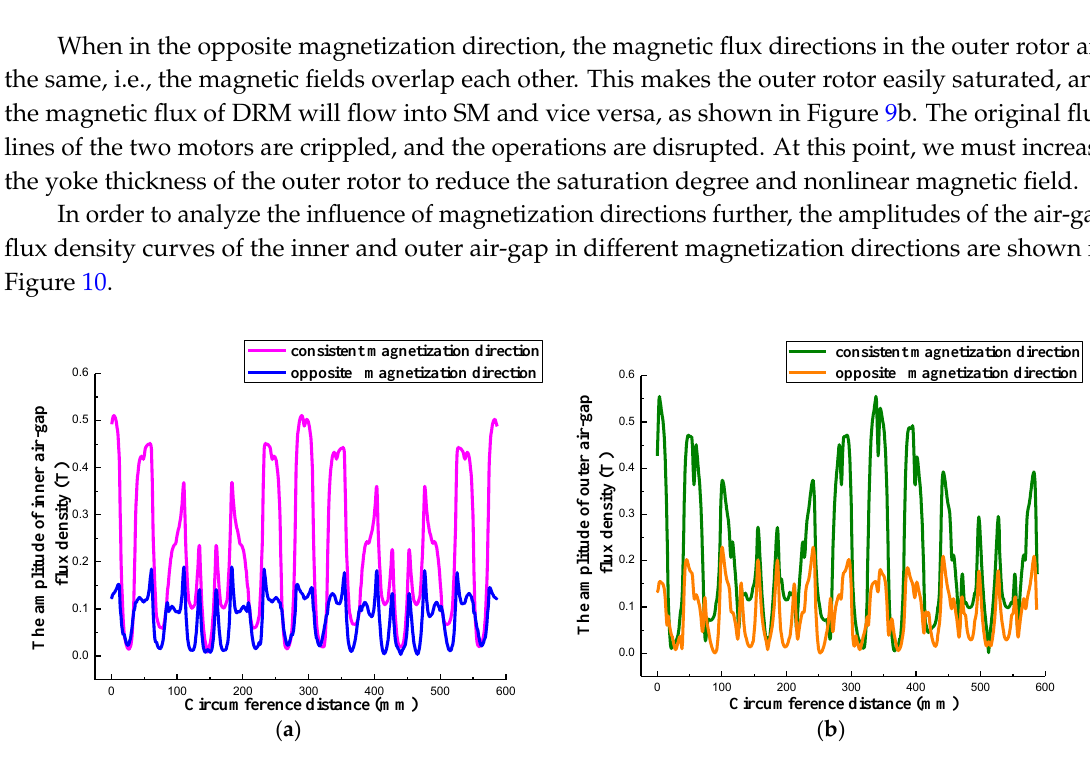
Figure 10. The amplitude of the air-gap flux density curves in different magnetization directions: ( a ) inner air-gap; ( b ) outer air-gap.